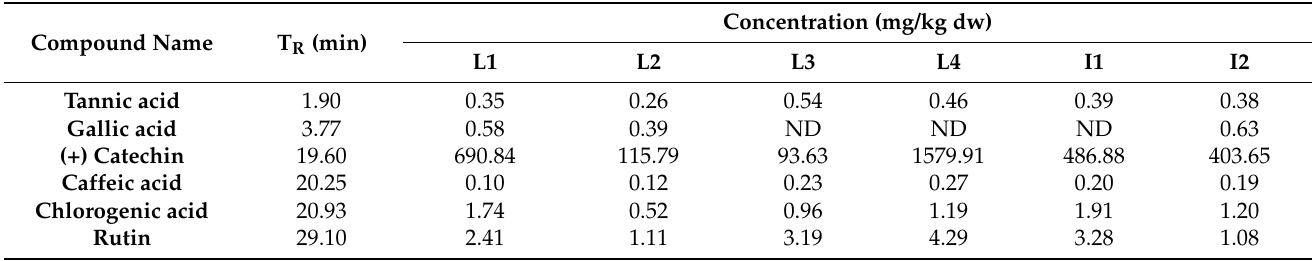
Table 8. Quantification data of identified PR varieties phenolic compounds by λ max each standard compound by HPLC-DAD analysis.